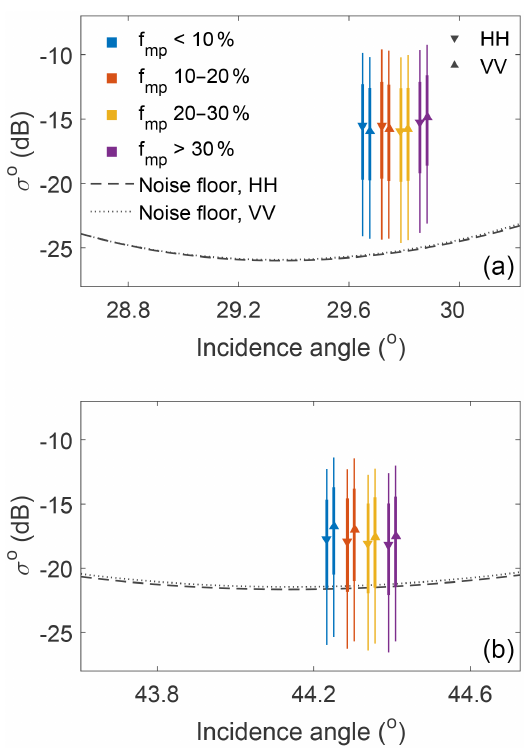
Figure 3. Signal-to-noise analysis of HH and VV channels for ar- eas with different f mp retrieved from the investigated floe in scene T3 (top) and T4 (bottom). The triangles display the median of σ 0 HH (dB) (upward pointing) and σ 0 (downward pointing). The thin line VV represents the part of σ 0 falling between the 10th and the 90th per- centile, while the thick line represents the part of σ 0 falling between the 25th and 75th percentile. Hence, the lines indicate the distribu- tions. All markers are offset from the middle position for